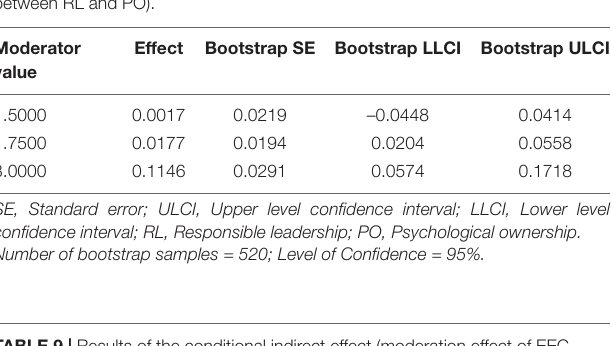
Figure 2 depicts an interaction chart that shows the moderation effect. It shows two lines interacting with each other at a point, so it indicates that there is moderation between responsible leadership and psychological